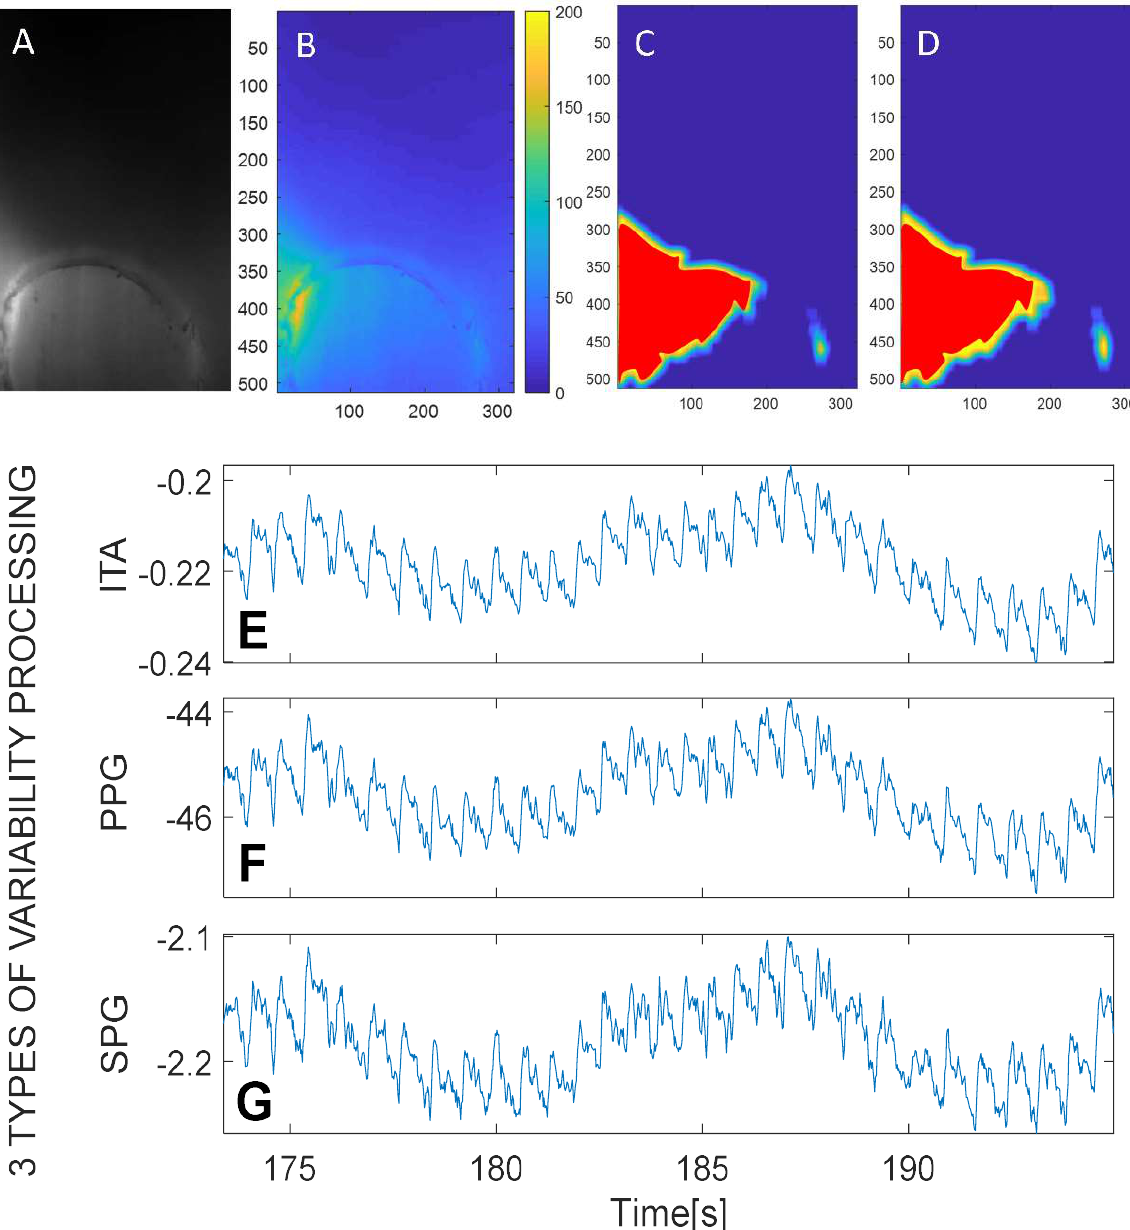
Figure 4. Expansion of the intensity pattern in transmission measurements causing spatial variability changes originated from absorption changes together with rPPG and rSPG. ( A ) Raw video image. ( B ) False color-coded intensity image. ( C ) Systolic (t = 183.1 s) portion of the false color-coded image above a certain intensity threshold. ( D ) Diastolic (t = 183.9 s) portion of the false color-coded image above the same intensity threshold. This area is somewhat expanded compared with C. ( E ) ITA pulsation. ( F ) Transmission rPPG. ( G ) Transmission rSPG. Note that raw waveforms are displayed vertically inverted, as is common practice for commercial PPG and SPG signal outputs. PPG and SPG synchronous signals from a random subject with 1200 μ s integration time.